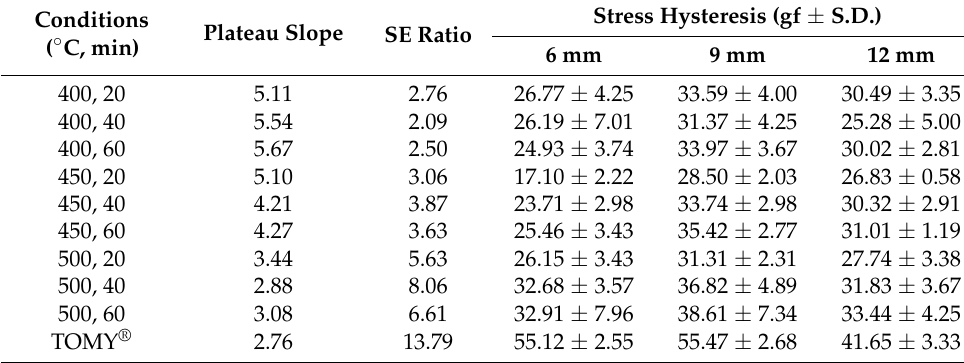
Figure 5. Superimpose of load-extension curves of custom-made NiTi closed coil springs under different heat treatment conditions with commercial NiTi closed coil springs (TOMY ® ); ( a ) at a constant time (20 min) with various temperatures; ( b ) at a constant time (40 min) with various temperatures; ( c ) at a constant time (60 min) with various temperatures. Table 3. Plateau slope, SE ratio, and means of stress hysteresis at different heat treatment conditions.